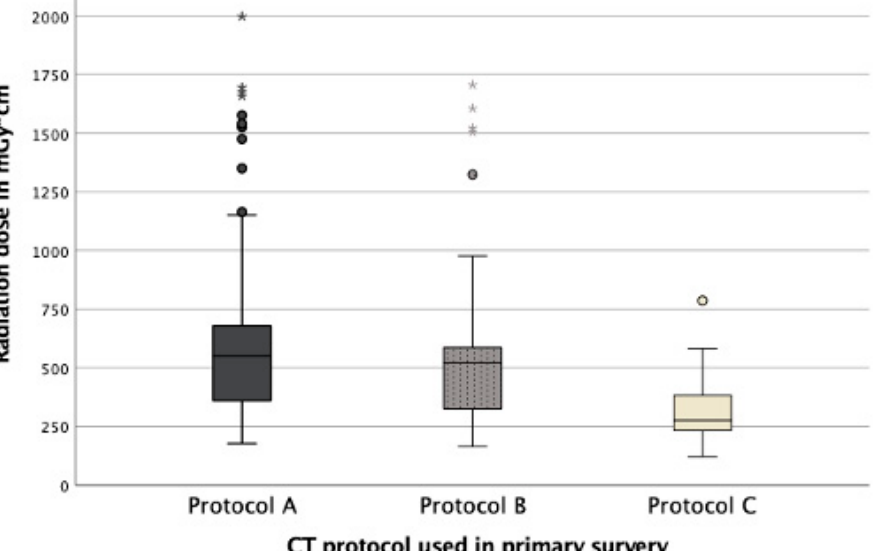
Figure 4. Comparison of medians and interquartile ranges of radiation dose depending on the CT protocol applied. No difference between the radiation doses of protocol A and B could be detected ( p = 0.123), but between protocols A and B compared to protocol C ( p < 0.001). The circles and stars (*) refer to radiation doses outside the interquartile ranges.